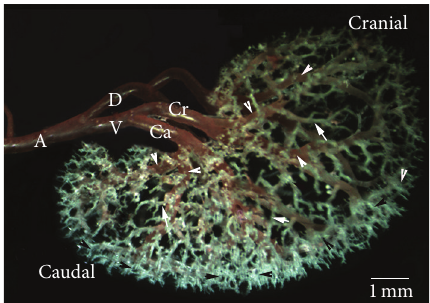
Figure3:Dorsalviewoftheintrarenalbranchesoftherenalarteries, Type Ib. A: renal artery: V: the ventral branch of renal artery; D: the dorsal branch of renal artery; Cr: the cranial division of the renal artery; Ca: the caudal division of the renal artery; a: first interlobar branch from the renal artery for the cranial pole; white arrowhead; interlobar